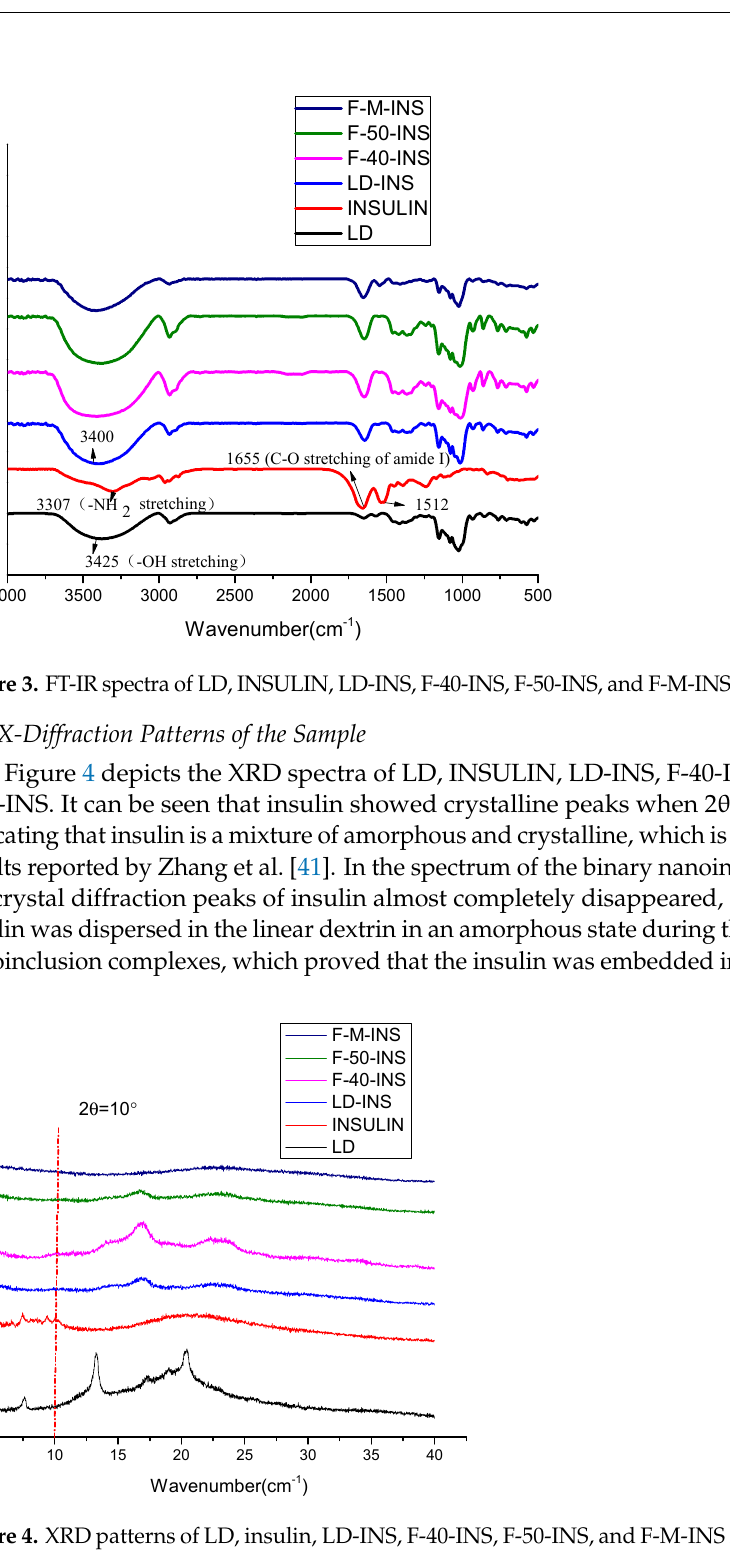
Figure 4. XRD patterns of LD, insulin, LD-INS, F-40-INS, F-50-INS, and F-M-INS inclusion com- plexes.